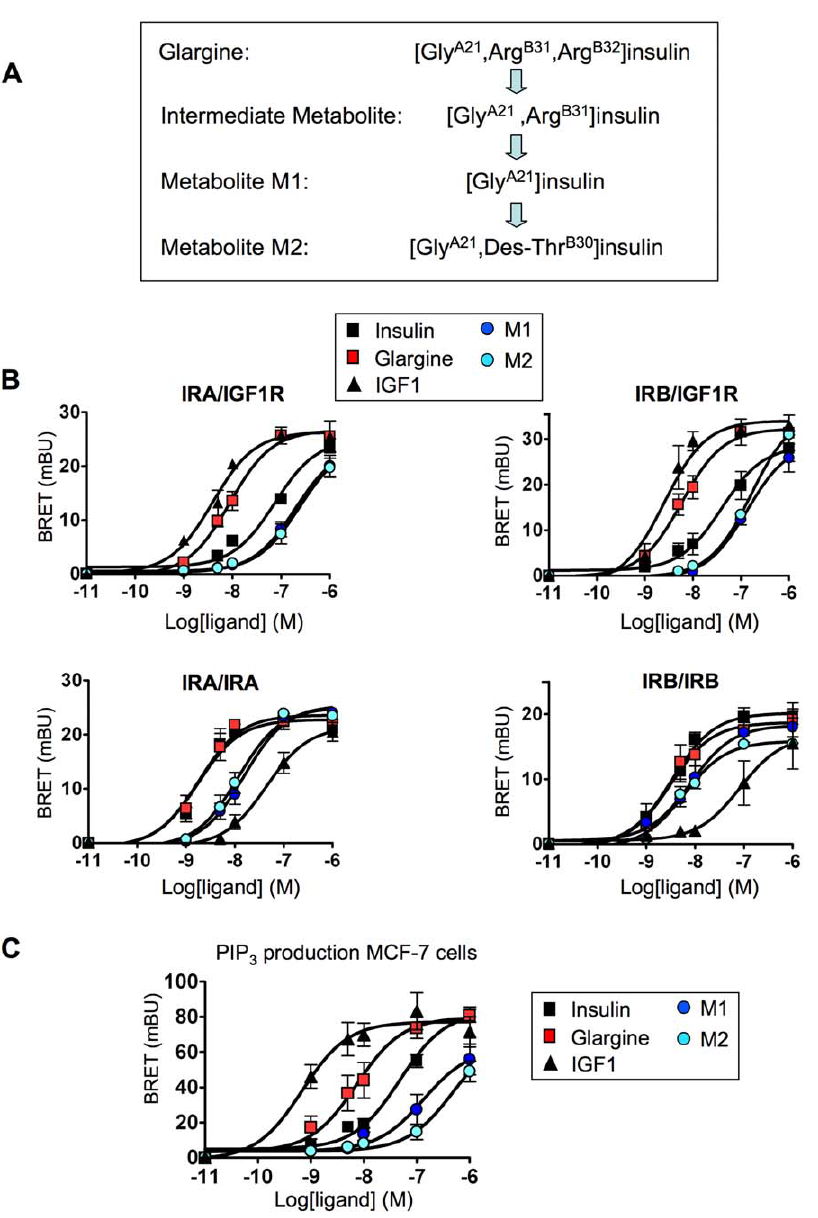
Figure 3. Comparison of the pharmacological profiles of glargine and its metabolites M1 and M2. (A) Conversion of glargine into M1 and M2 metabolites. (B) Effects of M1 and M2 on IR/IGF1R hybrids and on IR/IR homodimers. Receptors were prepared as described in figure 1. BRET assays were performed in the presence of increasing concentrations of insulin, glargine, M1, M2 or IGF1. (C) Dose-dependent effect of insulin, glargine, M1, M2 or IGF1 on PIP 3 production in MCF-7 cells. BRET assays were performed in the presence of increasing concentrations of ligands. Ligand-induced BRET (BRET above basal at the plateau) was determined for each ligand concentration and was used to establish dose-response curves. Results are the means 6 S.E.M. of 4 to 6 independent experiments. EC50 for insulin, IGF1, glargine and its metabolites are given in Table 3 and 4.